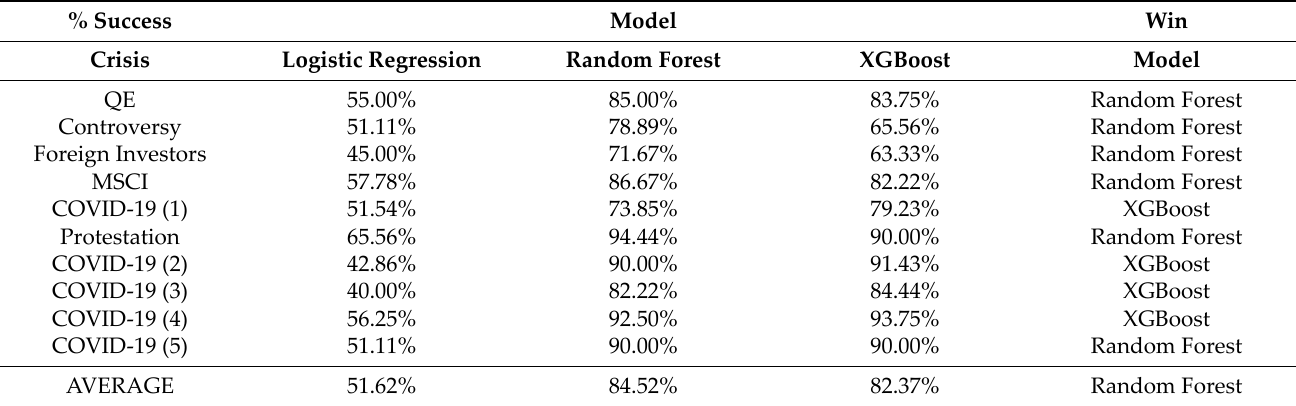
Table 8. Performance for crisis.